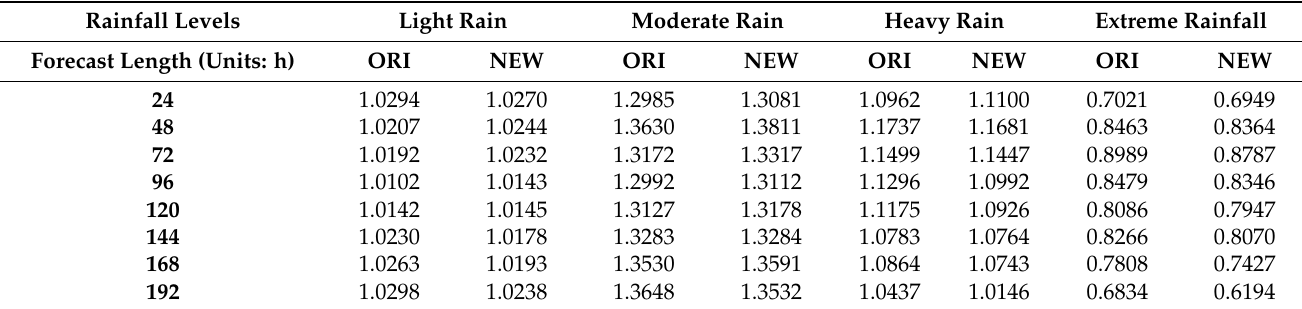
Table 6. BIAS of precipitation at different rainfall levels over East Asia.